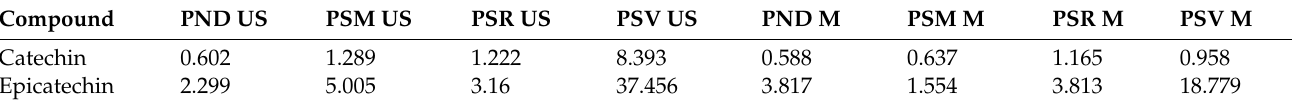
Table 2. Semiquantitative results of the polyphenolic compounds identified in the pine bark extracts (mg/g bark). Compound PND US PSM